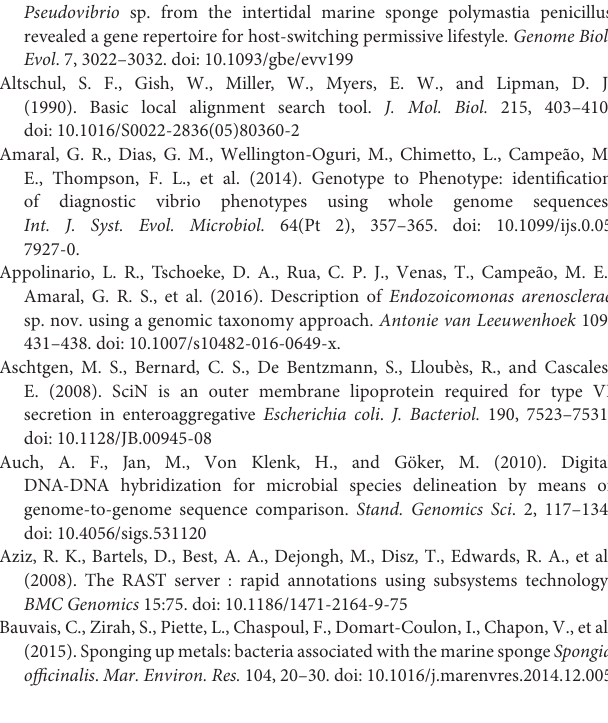
Figure S4 | NRPS pathway cluster identified in the P. brasiliensis Ab134 T genome.